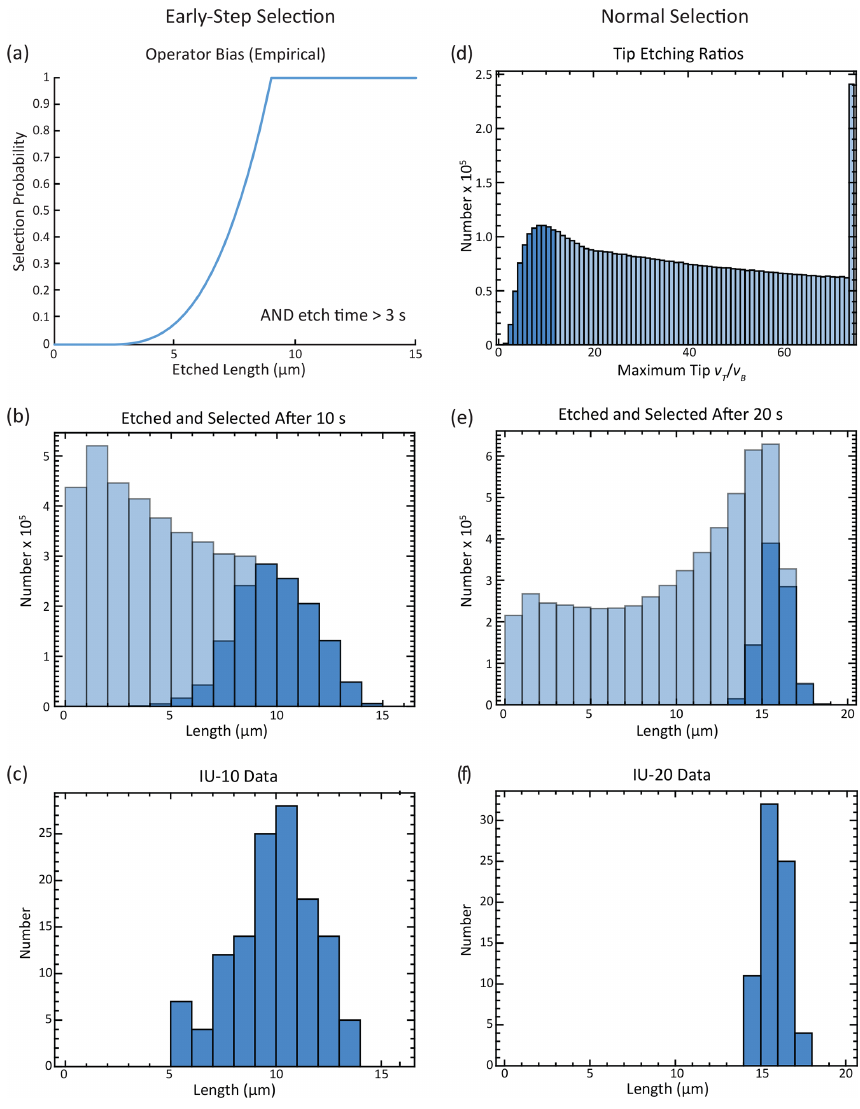
Figure 10. Illustration of how selection criteria for confined fission tracks affect length distributions. In all histograms, darkened bars show etched tracks that pass selection criteria, and faded bars show etched tracks that do not. (a) Empirical probability function for track selection when the first etching step is below 20s and when the analyst accepts most tracks found. (b) Model histogram for all etched tracks after 10s (unannealed induced). (c) Measured track lengths after 10s of etching (experiment IU-10). (d) Model v T /v B distribution of unannealed induced tracks after 20s of etching, with darker bars showing tracks with v T /v B ≤ 12. (e) Model histogram of all etched tracks after 20s when the analyst uses selection criteria employed for standard fission-track analysis. (f) Measured track lengths after a single 20s etch (experiment